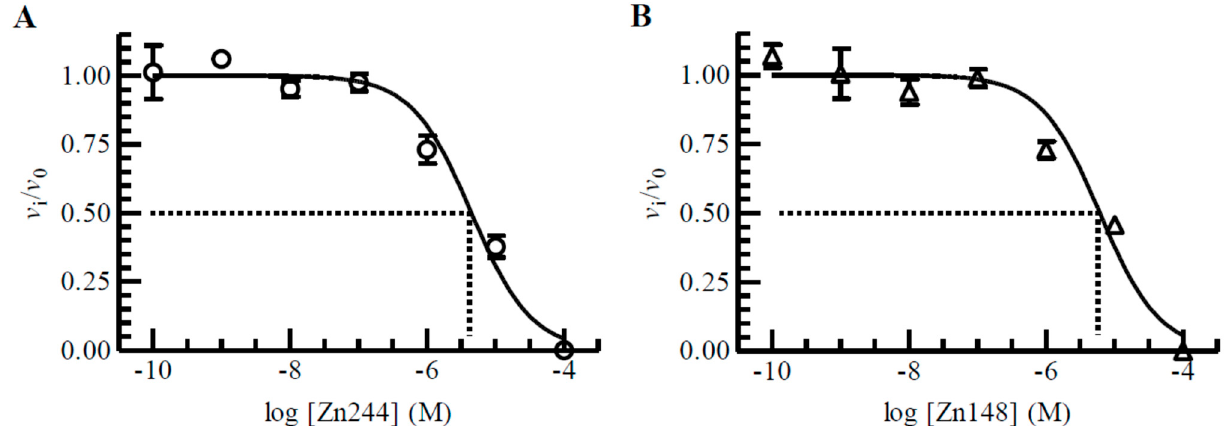
Figure 4. Dose–response plots of Zn244 ( A ) and Zn148 ( B ) for PLN. The enzyme with and without inhibitor was pre-incubated for 30 min at room temperature and the reaction started by adding McaRPPGFSAFK(Dnp)-OH (4 μ M in assay), where v i and v 0 are initial reaction rates in the presence and absence of Zn244 and Zn148. Each point on the curve shows the mean ± s.d. (N = 3 for all points in ( A ) and N = 4 for all points in ( B ) with regression coefficients r 2 of 0.97 in ( A ) and 0.95 in ( B ), giving an IC 50 value of 4.46 ± 0.05 μ M and a K i value of 4 ± 1 μ M for Zn244 ( A ) and an IC 50 value of 6.07 ± 0.08 μ M and a K i value of 5 ± 2 μ M for Zn148 ( B ). The large s.d. of the K i values compared to Table 1. K i values of the TPA, DPA and TPED derivatives for MMP-14, MMP-9, ALN, PLN and TLN. K i values determined for both bacterial and human metalloproteases using two different flu- orescence quenched peptide substrates, McaRPPGFSAFK(Dnp)-OH (for TLN, PLN and ALN) and McaPLGL(Dpa)AR-NH 2 (for MMP-9 and MMP-14). The concentration of the substrates used was 4 μ M except for ALN where it was 5 μ M and the highest concentration of the inhibitor compounds tested was 100 μ M. K i values were only obtained for compounds where 100 μ M of the compound reduced the enzymatic activity by 60% or more, as described in the main text. Compound and en- zyme were pre-incubated for 30 min at room temperature and the reaction was started by the addi- tion of substrate as described in Materials and Methods.